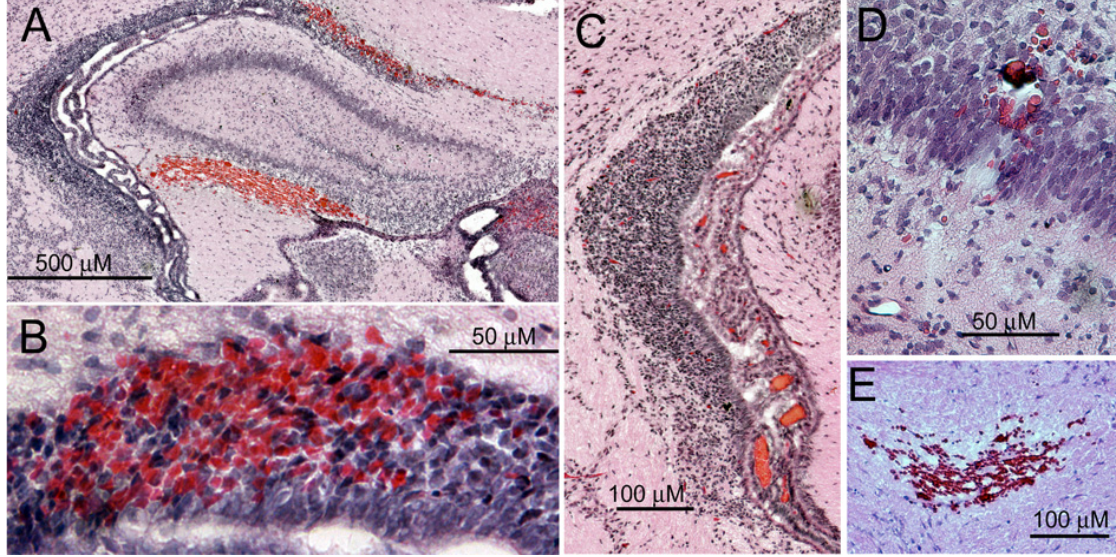
Figure 3. Tandem insults of intrauterine ischemia (IUI) and postnatal elevation in venous pressure cause periventricular hemorrhages. ( A – E ) Hematoxylin and eosin (H & E)-stained sections of brains from three rat pups 24 h after the second of 2 tandem insults showing hemorrhages involving white matter near the hippocampus ( A ), the subventricular zone ( B ), the choroid plexus ( C ), the CA3 region of the hippocampus ( D ) and the internal capsule ( E ); all animals underwent transcardial perfusion with normal saline to remove intravascular blood and leave only extravasated blood; the images shown are representative of data from 10 brains after tandem